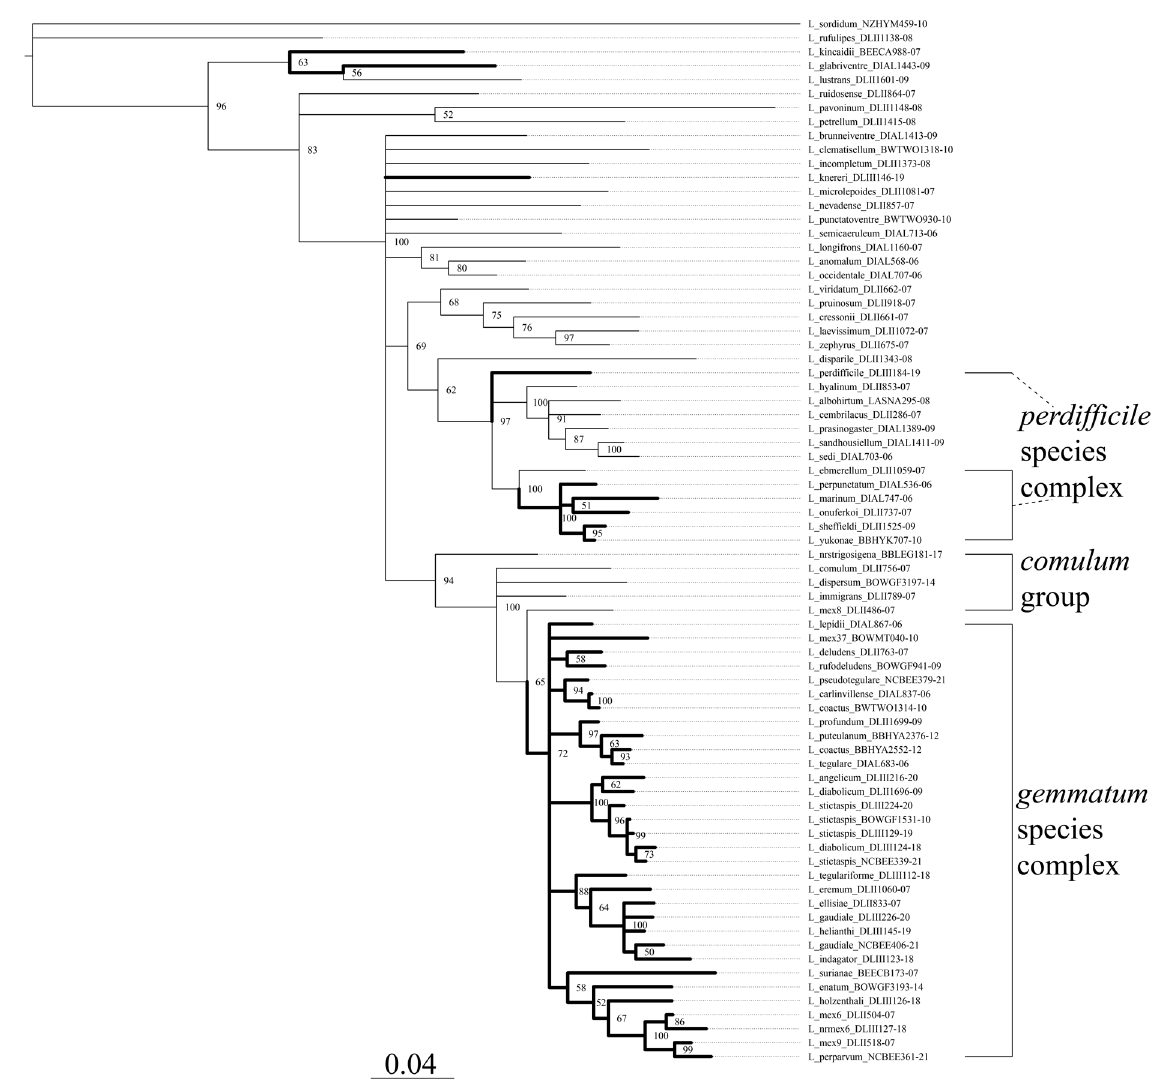
Fig. 2. 50% majority-rule consensus tree of species of Lasioglossum Curtis, 1833 with enlarged tegulae and representatives of other major lineages, based on 654-bp COI sequences and 15 morphological characters. MCMC tree search was performed in MrBayes ver. 3.2.7 using a GTR+I+Γ4 model for the molecular data, gamma-distributed rate variation for the morphological data, partitioning by data type, two simultaneous runs with 8 chains each, temperature of 0.0375, 20 000 000 generations, and L. sordidum (Smith, 1853) set as the outgroup (other settings program defaults). Node labels are posterior probabilities. Taxa names are followed by their BOLD accession numbers. Bold branches on the tree are species with enlarged